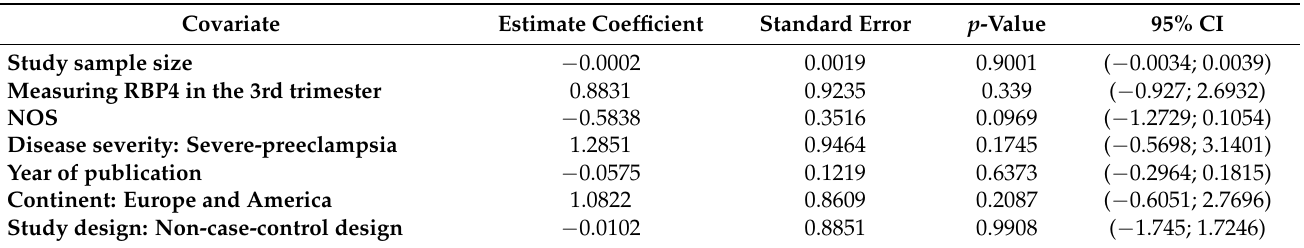
Table 3. Meta-regression analysis for the factors that could affect the SMD of RBP4 in association with